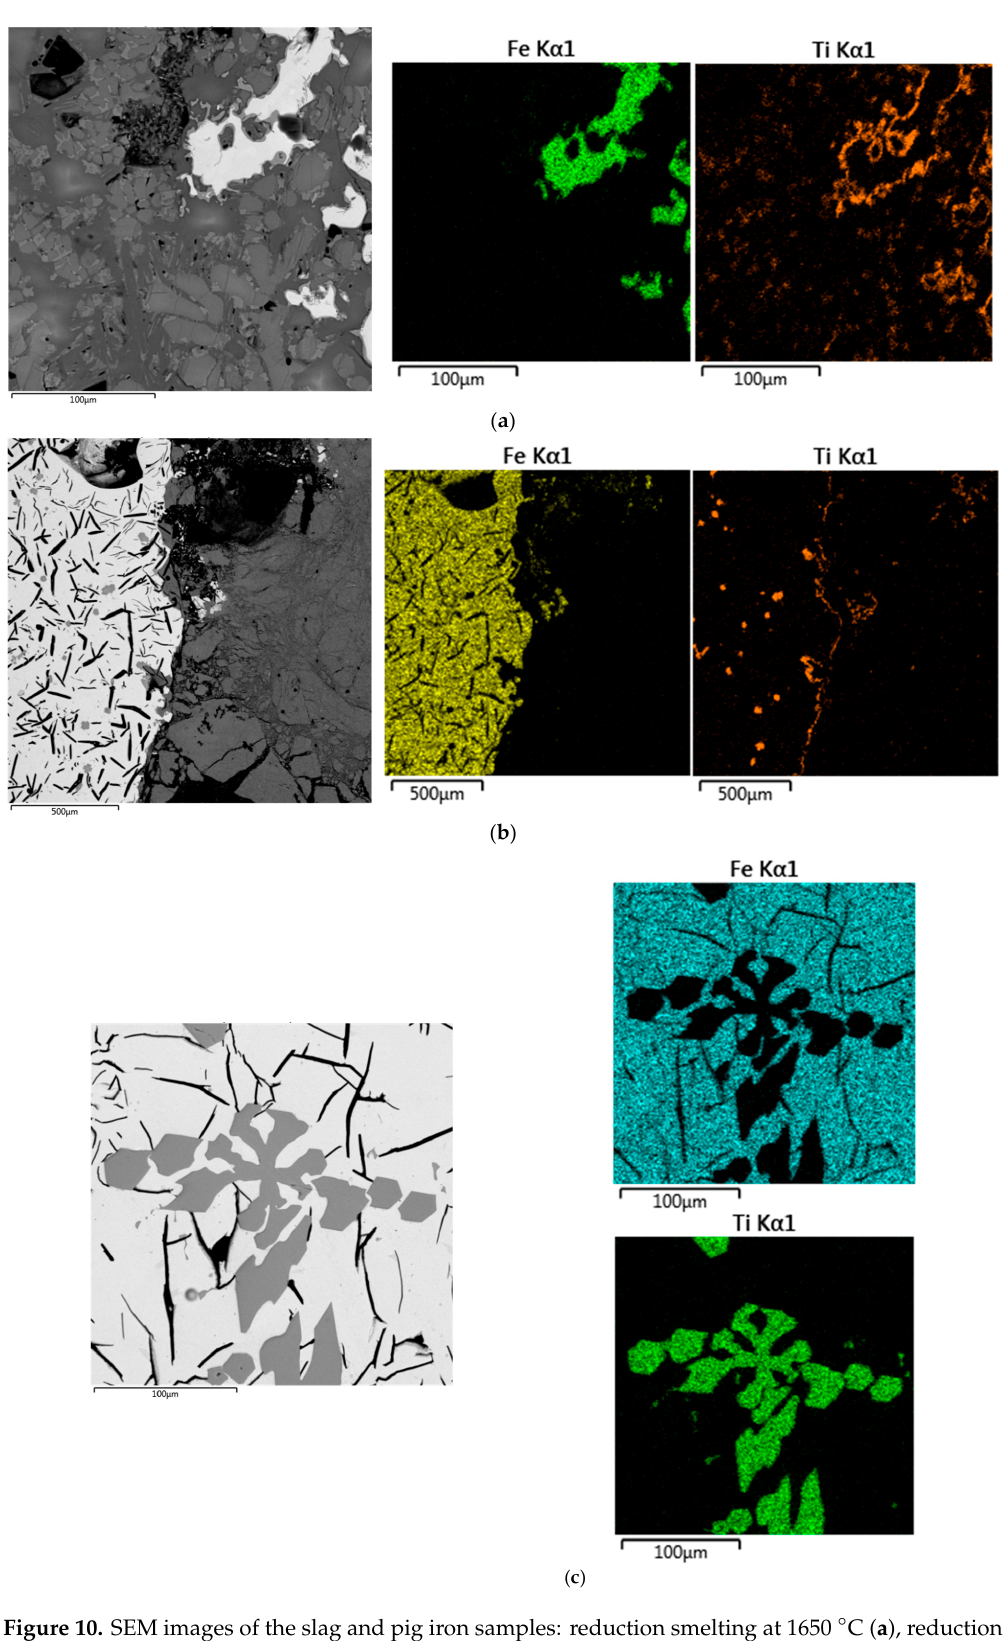
Figure 10. SEM images of the slag and pig iron samples: reduction smelting at 1650 ° С ( a ), reduction smelting at 1750 ° С ( b ), titanium carbide in pig iron ( c ) (the mapping shows distribution of Fe and Ti).